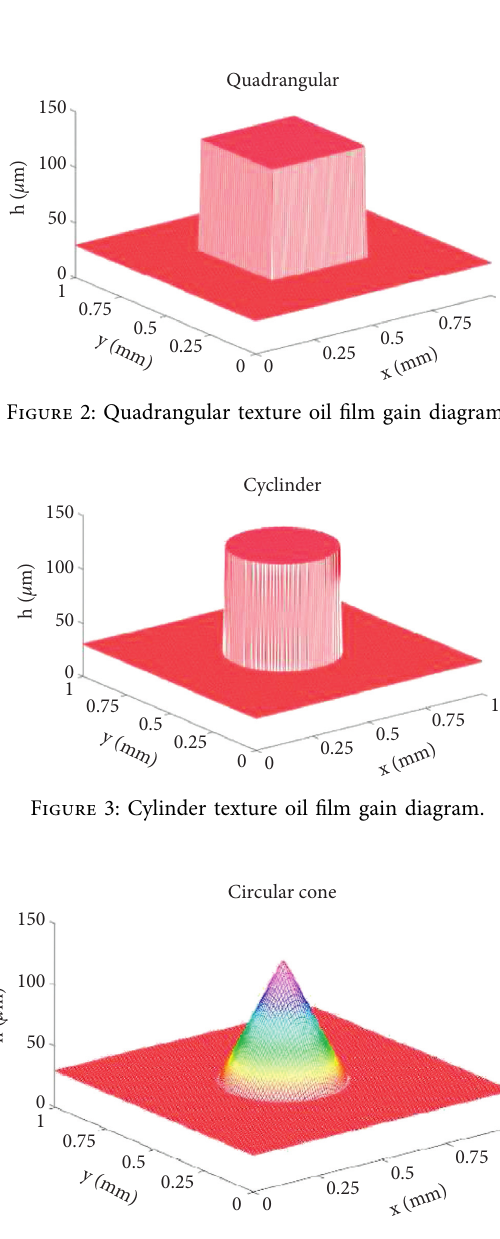
Figure 4: Circular texture oil film gain